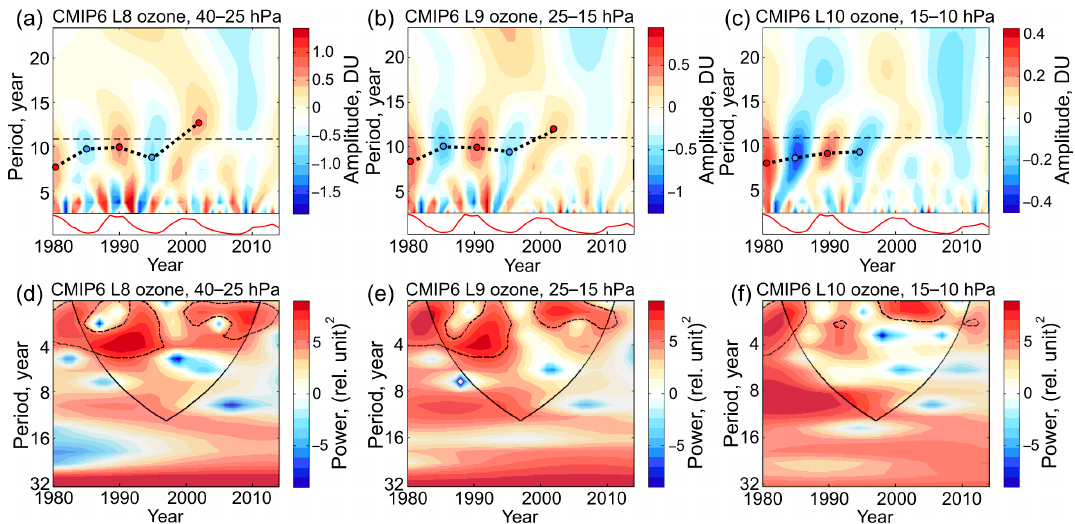
Figure 10. ( a – c ) Wavelet amplitude and ( d – f ) wavelet power spectrum for CMIP6 ozone over Faraday/Vernadsky in the layers ( a , d ) L8, ( b , e ) L9, and ( c , f ) L10, where SBUV data show statistically significant quasi-11-year periodicity.